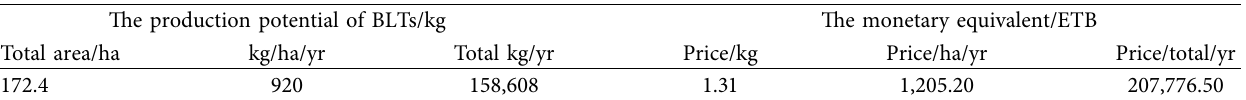
Figure 6: Te “split wood” (a) and the bale of litter (b) probably from an illegally logged Surra government plantation during the semiwet season (sources: photo flmed from feld by their consent, 2021). Table 5: Te total production potential of BLTs/kg/ha and kg/year and its corresponding monetary values of the Surra subeucalyptus plantation.